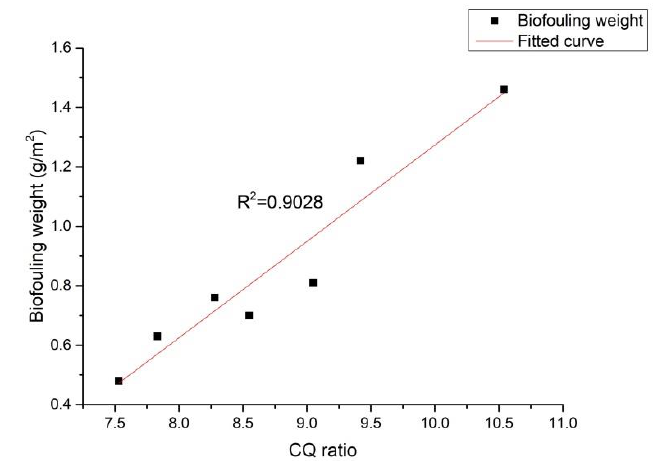
Figure 9. E ff ect of the CQ ratio on the weight of the iron bacteria